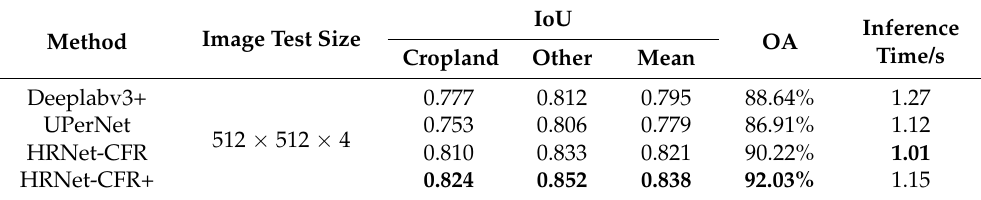
Table 4. The performance of different methods compared in the GID dataset. Note: the records in bold represent the best on the GID dataset.